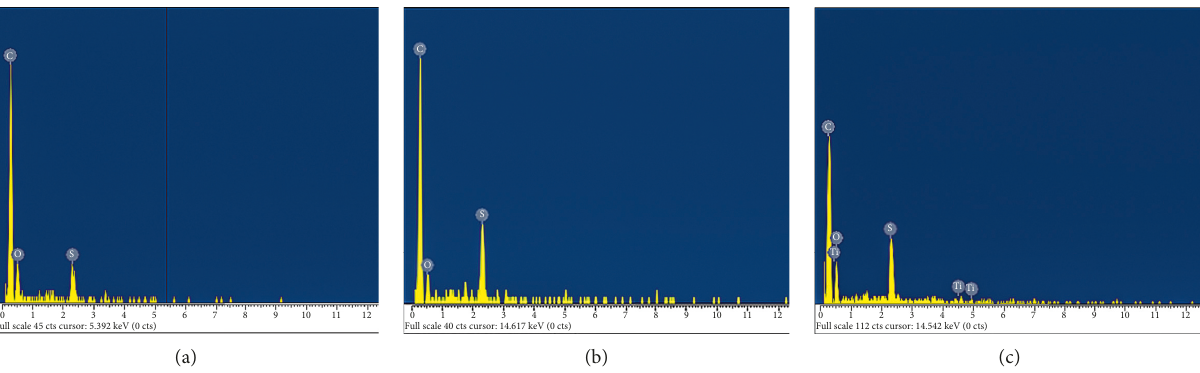
Figure 7: EDX spectra of PSf (a), PSf/GO (b), and PSf/GO-T15 (c) membranes.